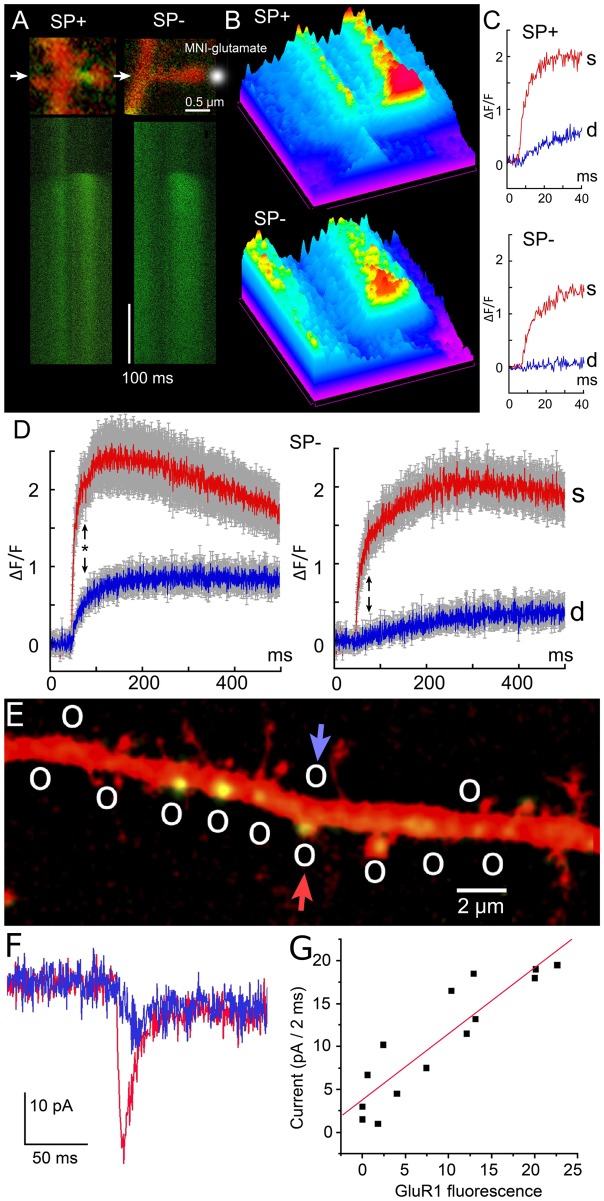
Effect of MNI-caged glutamate photolysis on spine-dendrite coupling in SP positive and negative spines.(A top) Examples of two SP+ and SP− spines as revealed by immunocytochemical analysis, done after the recording experiments. Transfected cultured hippocampal cells were microinjected with 200 μM K+ Fluo-4 and calcium transients as fast 0.35 ms/line line scans (A bottom) were recorded following single 4 ns 355 nm Nd:YAG laser flash (third harmonic of 1,064 nm). (B) Same line scans, presented as spectrum-colored surface plots, oriented from bottom right to top left with magenta–blue corresponding to low fluorescence and yellow–red to high Fluo-4 fluorescence. (C) Examples of the initial stage of calcium transients (during the first 30 ms) from SP+ and SP− spines. (D) Summarized graphs presenting 23 SP+ spine/dendrite pairs and 22 SP− spine/dendrite pairs. Averaged spine lengths were 1.1 ± 0.13 μm for SP+ and 1.15 ± 0.15 μm for SP− spines. Note faster and higher calcium rise in the dendrites SP+ versus SP− parent dendrites and faster decay time in the SP+ spine heads. Black arrows indicate 80 ms: P value based on ANOVA for (SP+/SP−) spines is 0.011, while for (SP+/SP−) dendrites is 0.038, respectively. (E) Multiple uncaging locations (circles) of glutamate along the dendrite (transfected with GluR-1 [AMPA receptor] marked in green, to visualize the accumulation of GluR1 and transfected with DsRed for visualizing dendrite morphology), from typical cultured pyramidal neurons. Glutamate is uncaged at several GluR-positive and GluR-negative locations. (F) Patch clamp responses to glutamate uncaging located by the arrows (in panel E) at a dendritic spine (red, GluR-1-positive) and on the dendritic shaft (blue, GluR-1-negative). (G) Overall correlation between GluR-1 fluorescence and recorded current following uncaging [41]. Data used for generating D and G is available in S1 Data. AMPA, α-amino-3-hydroxy-5-methyl-4- isoxazolepropionic acid; GluR-1, glutamate receptor 1; SP, synaptopodin.